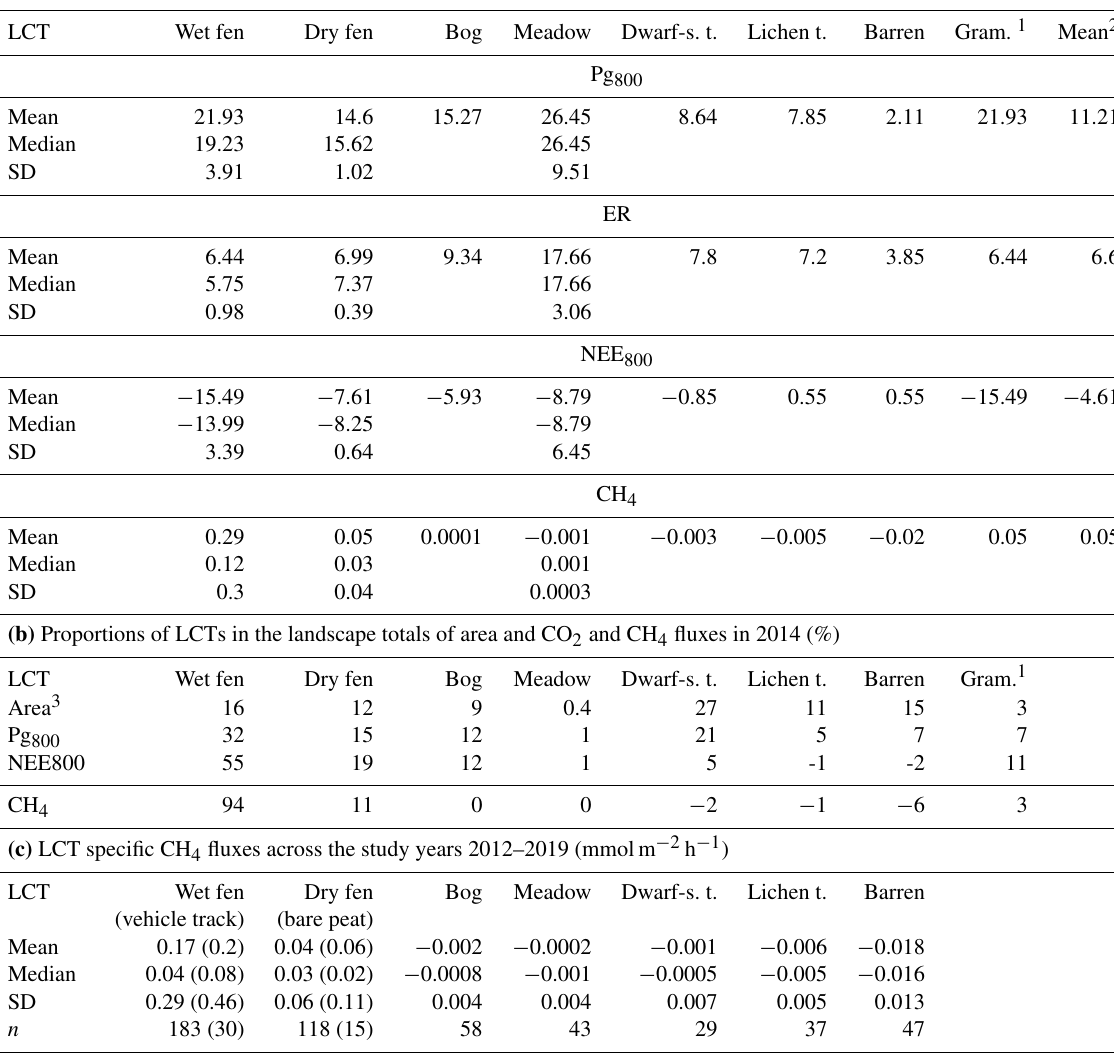
Table 3. (a) Means, medians, and standard deviations (sd) of LCT specific CO 2 and CH 4 fluxes in 2014 calculated from collar specific esti- mates (CO 2 ) or seasonal means (CH 4 ). There were 15 or 16 data points per each collar and 1–3 collars per LCT (see Table 2). (b) Proportions of LCTs in landscape totals of area, and Pg 800 , NEE 800 , and CH 4 fluxes based on the LCT means (part a). (c) LCT specific means, medians, and standard deviations of CH 4 fluxes based on multiyear data ( n is number of the